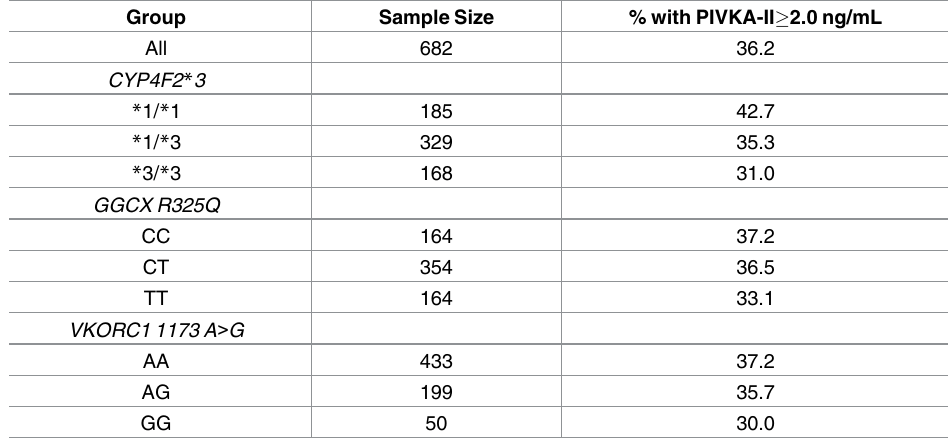
Table 5. Effect of CYP4F2 , GGCX and VKORC1 genotype on plasma